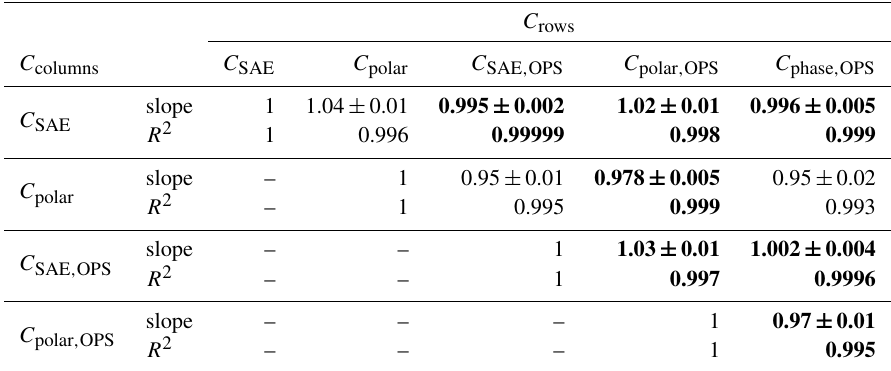
Table 5. Monodisperse aerosol: PSL and AS. Results of the regression analysis ( C rows = slope · C columns and coefficient of determination R 2 ) of each angular correction reported in the table rows C rows vs. each angular correction reported in the table columns C columns . Results within ± 3% are highlighted in bold.